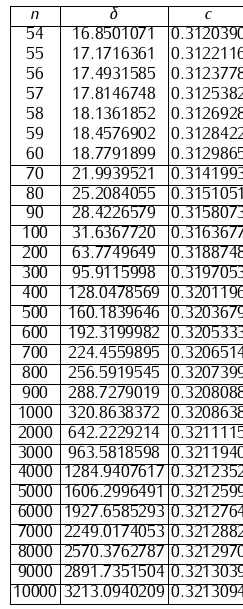
Table 1. Values of n , δ and c such that g